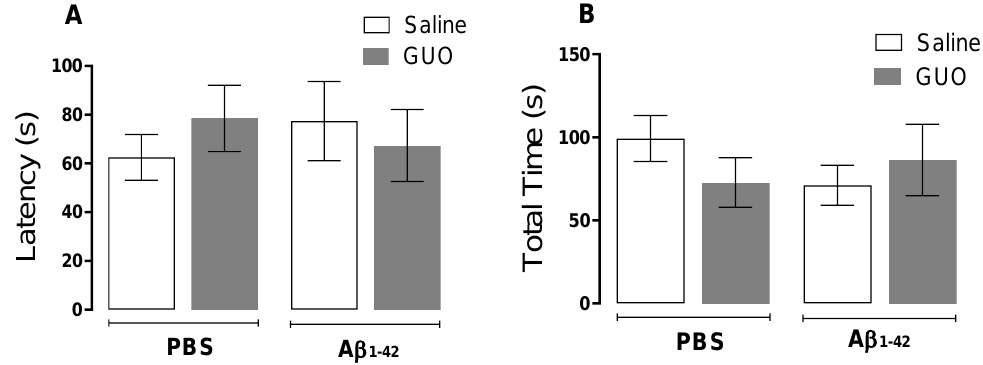
Figure 4. Evaluation of anhedonic-like behaviour in mice following guanosine treatment and A β 1–42 i.c.v. infusion. Mice subjected to A β 1–42 infusion (400 pmol/site) received guanosine (GUO, 8 mg/kg, i.p.) for nine days. On the tenth day, mice were subjected to the sucrose splash test and the latency to initiating grooming ( A ) and the total time spent in grooming activity ( B ) were measured. Values expressed as mean + S.E.M (n = 7 – 8). (Two- way ANOVA followed by Tukey’s test).